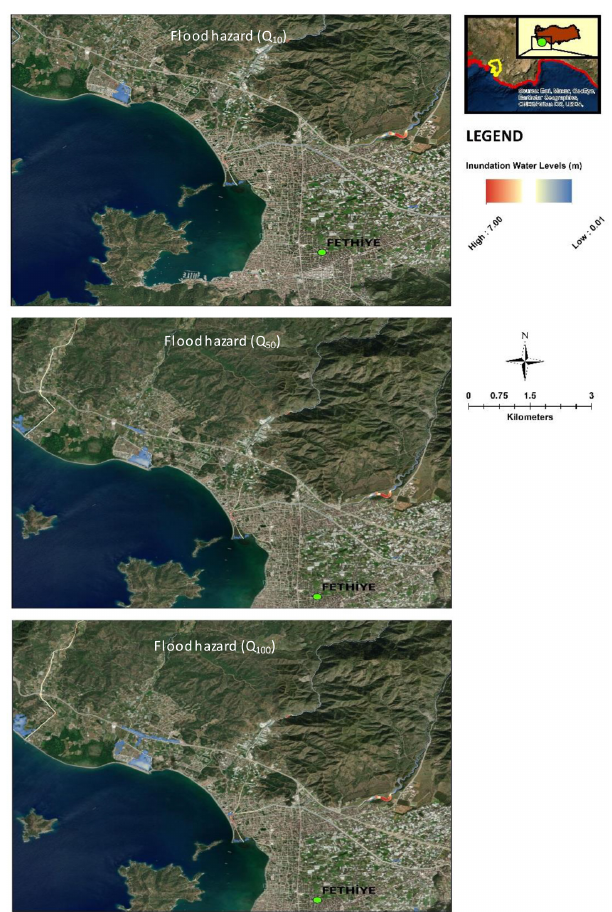
According to the hazard vulnerability classification pro- posed by Smith et al. (2014), all three flood events having different recurrence intervals (i.e., 10, 50, and 100 years) fall into the H1 hazard class, which can generate negligible ad- verse effects in some coastal parts of the city center. On